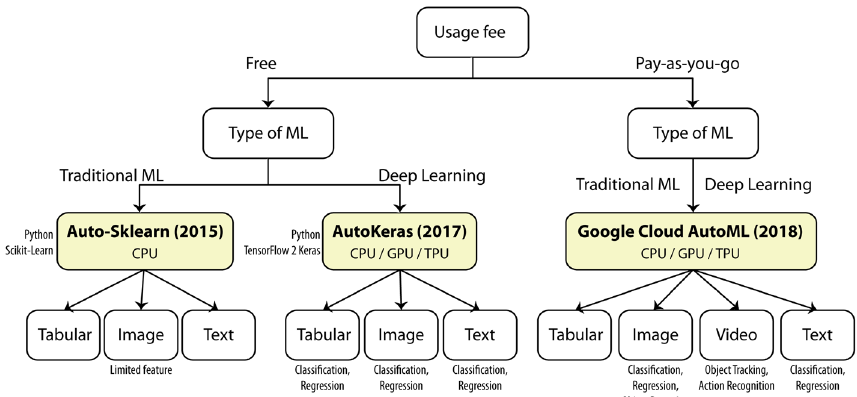
Fig. 3 Our decision diagram regarding the three AutoML frameworks discussed in “AutoML’s background”